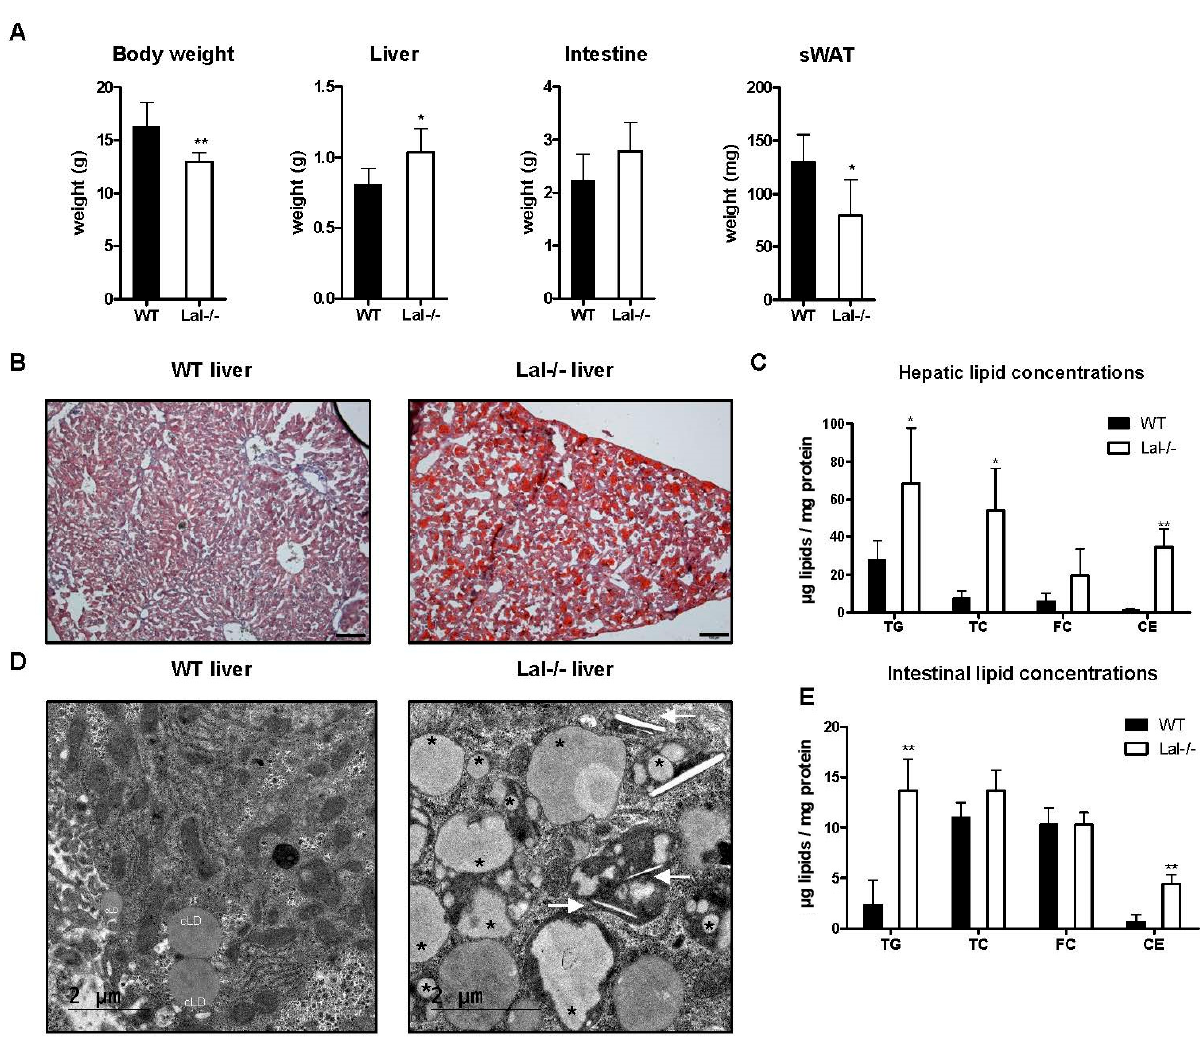
Figure 6. Aggravation of LAL deficiency during the first 4 weeks of life. Organs were isolated from WT and Lal-/- mice 4 weeks after birth. ( A ) Body and organ weights and ( B ) ORO staining of liver cryosections. Magnification, 10x; Scale bar, 100 µm. ( C ) Hepatic lipid concentrations ( n = 4 WT, 5 Lal-/-). ( D ) Electron micrographs of WT and Lal-/- livers; cLD, cytosolic lipid droplet; white arrows indicate lysosomal CE crystals, * indicate lysosomal lipids. Scale bar, 2 µm. ( E ) Intestinal lipid concentrations ( n = 4). Data represent mean values + SD. Statistically significant differences were calculated by two-tailed Student’s t -test: * p < 0.05, ** p ≤ 0.01.